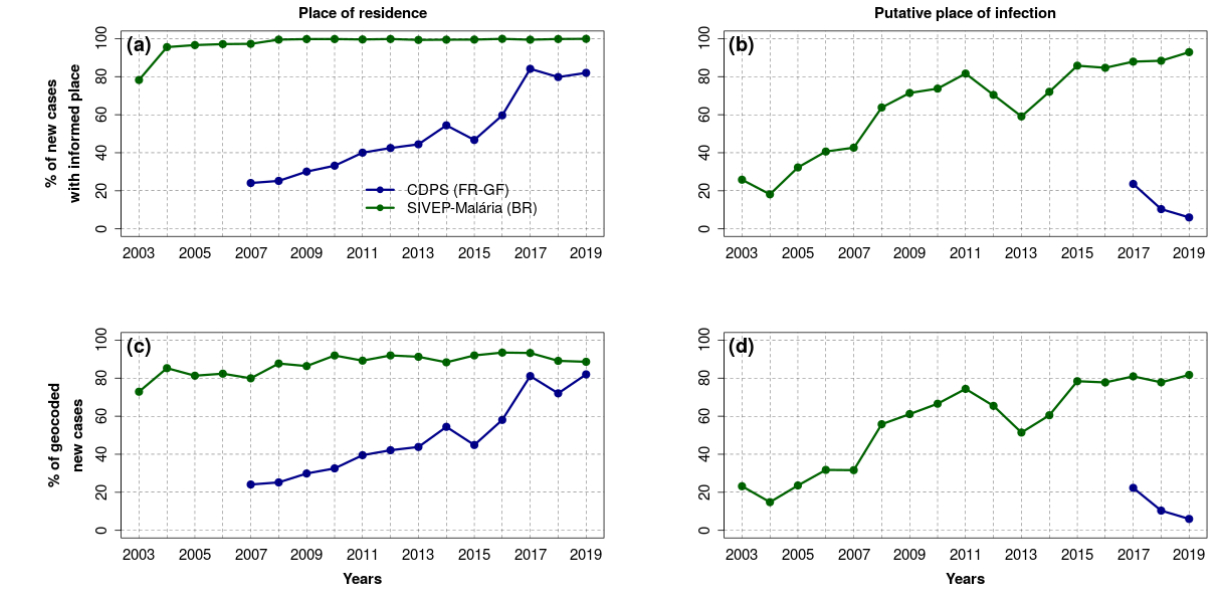
Figure 6. Percentage of malaria cases in the database of the Department of the Centers for Prevention and Care (Service des Centres Délocalisés de Prévention et de Soins [CDPS]) in French Guiana (FR-GF) and in the Malaria Epidemiological Surveillance Information System (Sistema de Informações de Vigilância Epidemiológica da Malária [SIVEP-Malária]) in Brazil (BR) associated with (a) a place of residence; (b) a putative place of infection; (c) a geolocalized place of residence; and (d) a geolocalized putative place of infection. Putative places of infection were not stored in the CDPS database before